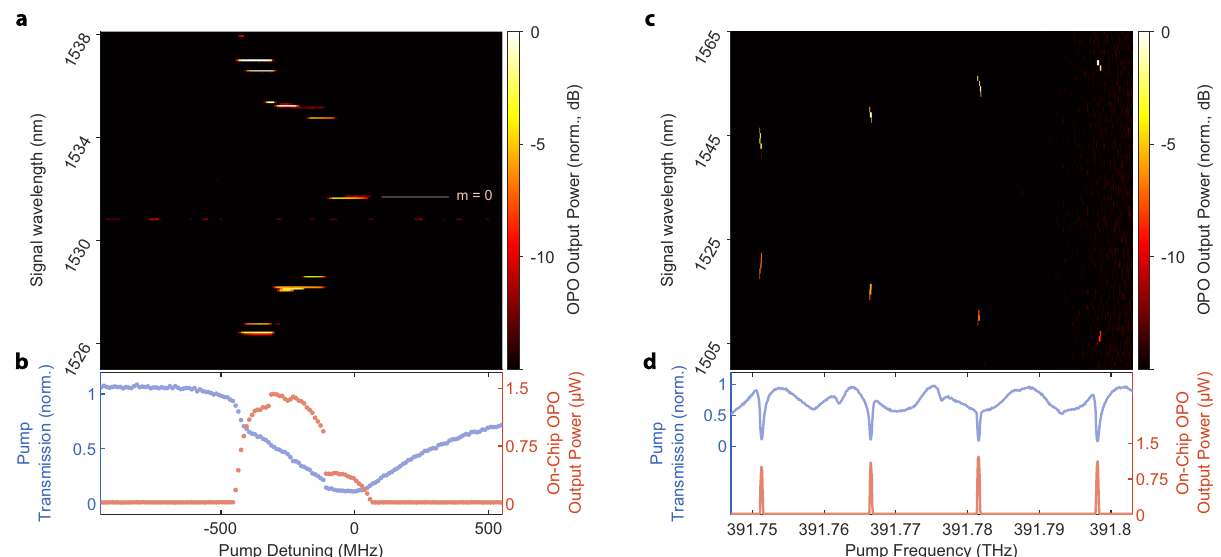
Fig. 5 Tuning between degenerate and nondegenerate optical parametric oscillation. a Tuning of the OPO close to μ = 0, at a pump power of 250 μ W. We observe degenerate parametric oscillation at 1531.7 nm ( m = 0) and nondegenerate operation for blue-detuning of the pump laser. b SH resonance lineshape (blue points) aligned with the OPO response (red points) collected above threshold with 250 μ W of on-chip pump power. The distinct feature at zero-detuning corresponds to degenerate oscillation. c Sweeping the pump laser over four neighboring modes shows that the signal/idler pair center frequencies are different for each OPO. This is due to the different modal detuning μ = 0 experienced by each OPO due to the difference in dispersion at 765 and 1530 nm. The higher frequency OPOs have larger ∣ μ ∣ (see discussion in the section “ Parametric oscillation theory ” ). This shows that additional tuning range of the device's output frequency can be extended to about 2.75 THz by utilizing multiple OPOs of a single resonator while keeping the chip temperature fi xed. d SH resonance lineshape (blue line) aligned with the OPO response (red line) collected above threshold at 250 μ W of pump power on